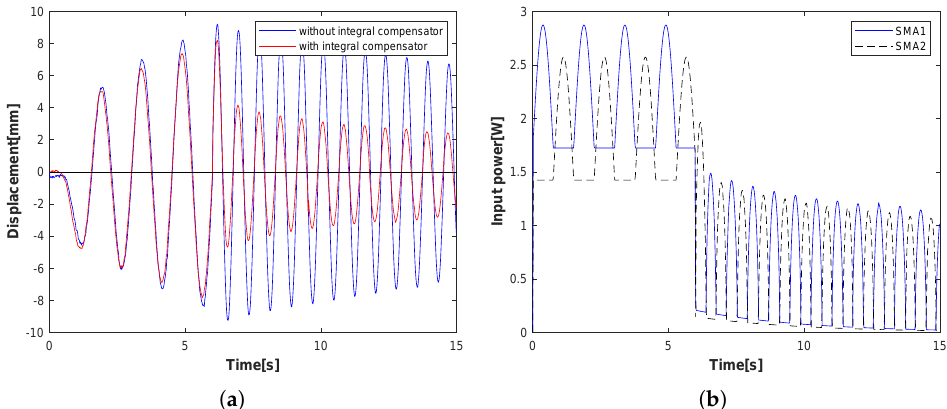
Figure 6. Experimental case 1: vibration control with/without integral compensator. ( a ) Displacement of the flexible arm. ( b ) Input power of SMA